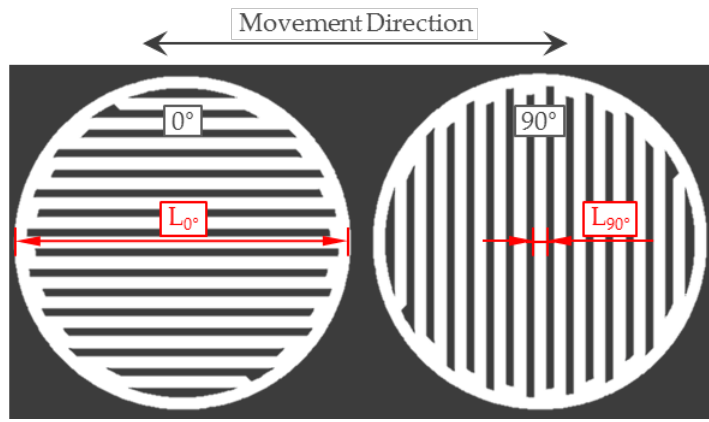
Figure 10. Change of the static friction length L depending on the orientation angle of the infill from 0 to 90° in relation to the direction of movement.